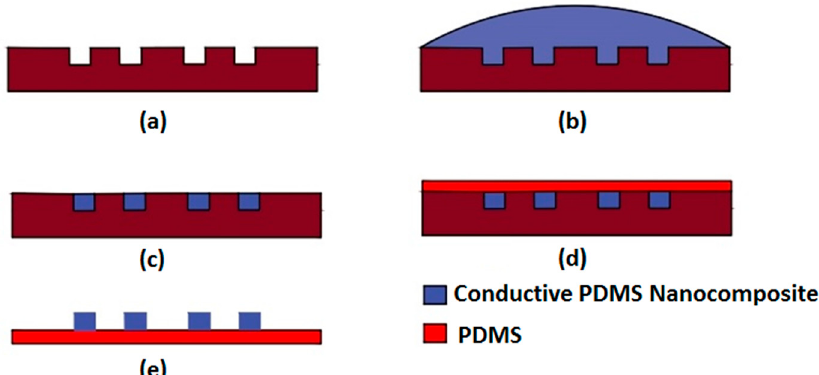
Figure 2. Schematic diagram of the hybridized fabrication process consisting of MWCNTs-PDMS-based nanocomposites. Reproduced from Khosla, A., Hilbich, D., Drewbrook, C., Chung, D. and Gray, B. L., 2011, February. Large scale micropatterning of multi-walled carbon nanotube/polydimethylsiloxane nanocomposite polymer on highly flexible 12 × 24 inch substrates. In Micromachining and Microfabrication Process Technology XVI (Vol. 7926, p. 79260L). International Society for Optics and Photonics [68] .